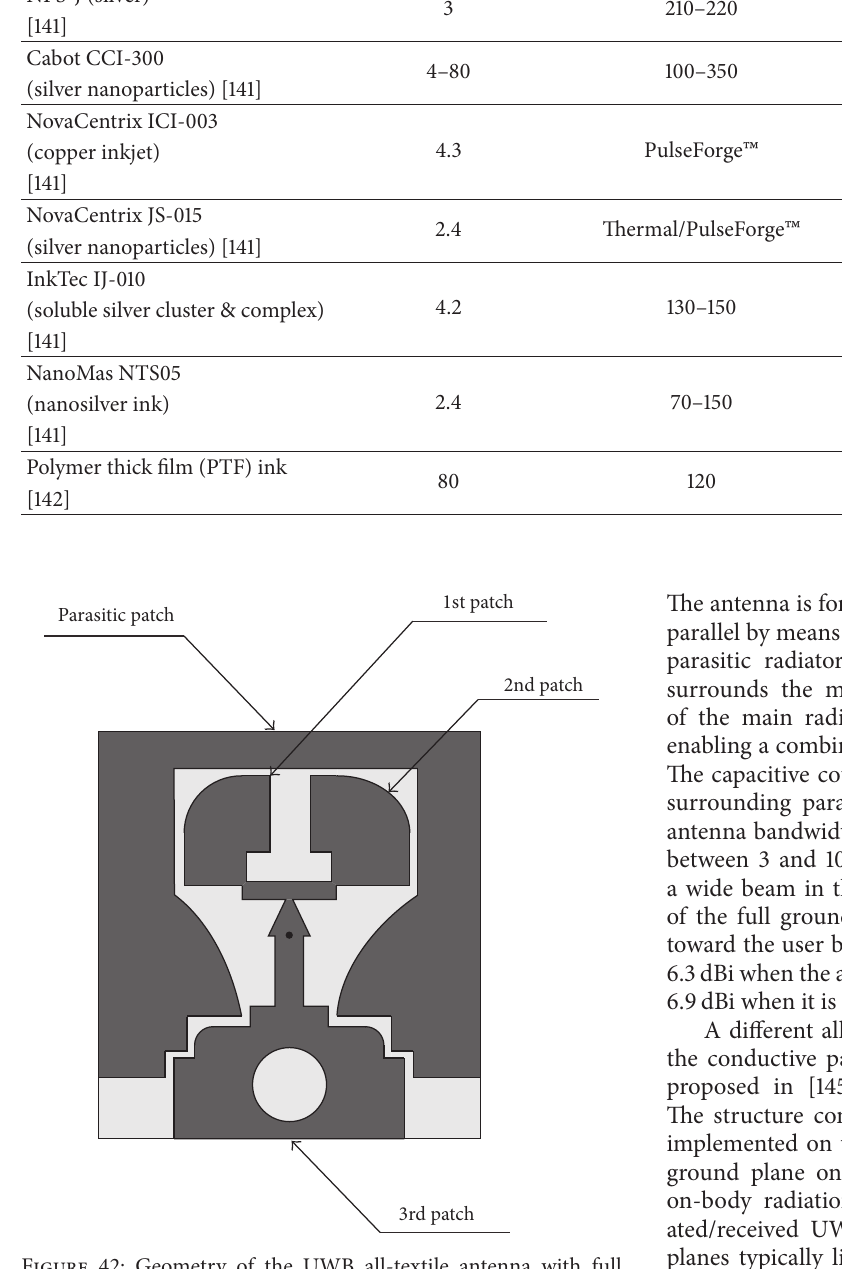
Figure 42: Geometry of the UWB all-textile antenna with full ground plane for off-body WBAN communications [144]. The three patches and the parasitic one forming the wearable antenna are indicated in the figure. The black dot point indicates the pin of the coaxial probe. Dark gray upper conductive textile and light gray dielectric textile